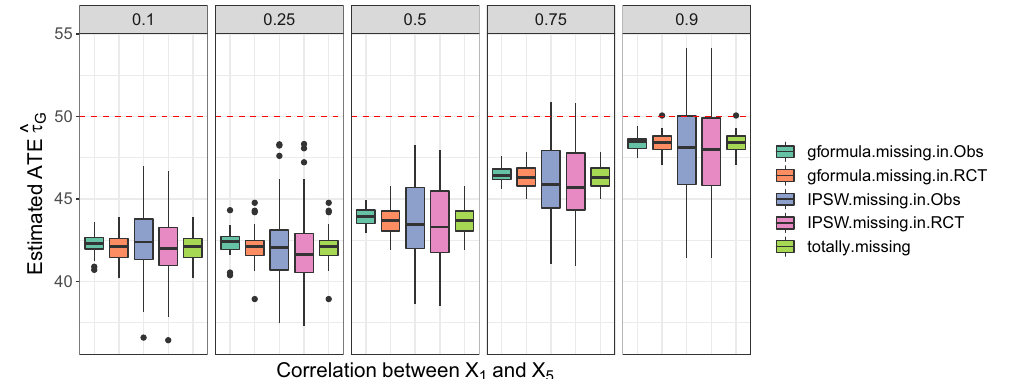
Figure A1: Simulations results when imputing ( procedure 4 ) : Results when imputing X 1 with a linear model fi tted on the complete data set ( either the RCT or the observational ) . All the missing covariate patterns are simulated using either the G - formula or the IPSW estimators. The impact of the correlation between X 1 and X 5 is investigated. Each simulation is repeated 100 times. All procedures have a similar bias as the procedure ignoring the partially missing covariate ( totally.missing ) , so that a linear imputation ( procedure 4 ) improves neither the bias nor the